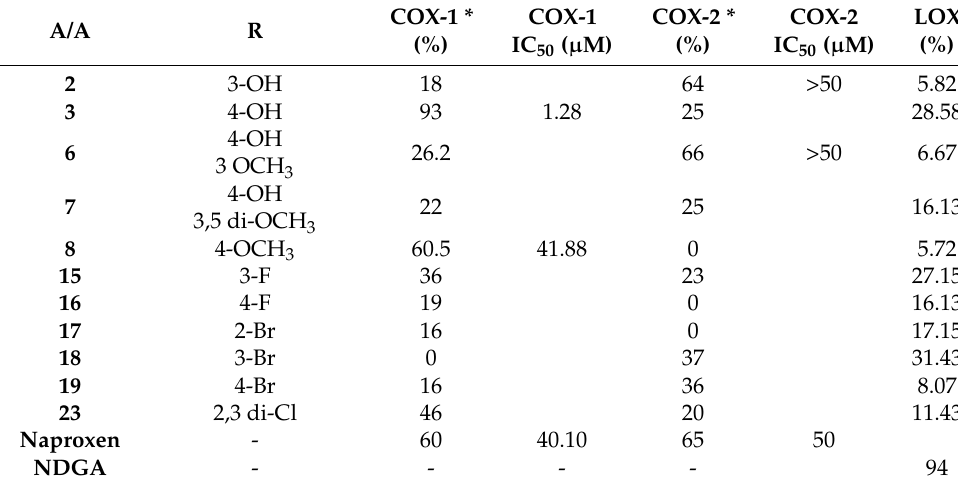
Table 2. Cyclooxygenase (COX-1/-2) inhibitory effects in